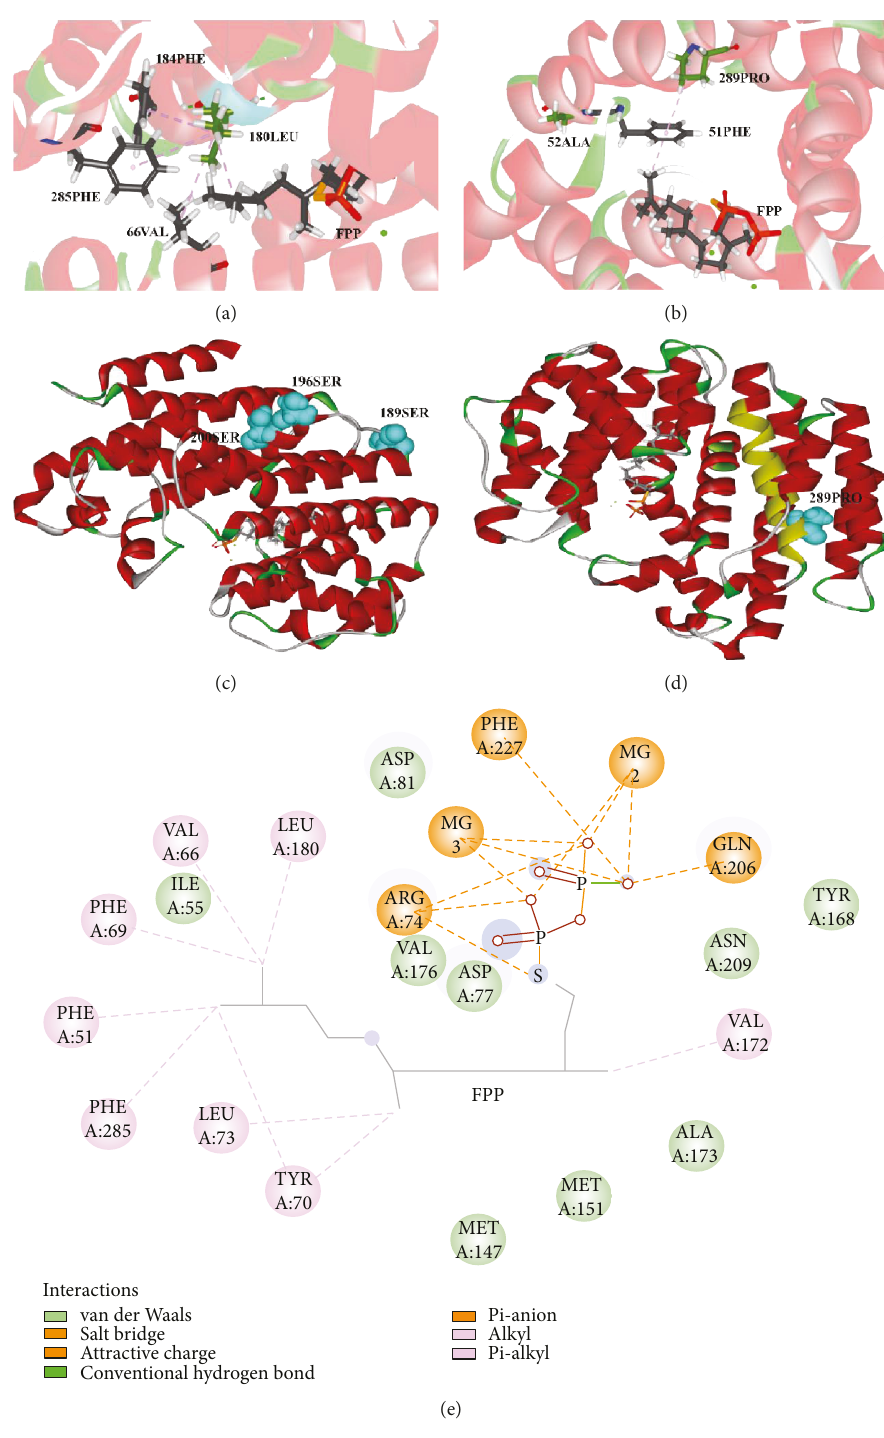
Figure 6: Sites of positive selection (52A, 180L, 189S, 196S, 200S, and 289P) on the GpSS model using DSV. (a) 180Leu was connected with FPP, 66Val, 184Phe, and 285Phe by nonbonded interactions. (b) 52Ala and 289Pro were connected with FPP and 51Phe. (c, d) Distribution of 189Ser, 196Ser, and 200Ser and 289Pro on the GpSS 3D structure. Yellow areas indicate transmembrane domains. (e) Relationship between GpSS receptors and ligands (FPP). Dashed lines indicate nonbonded